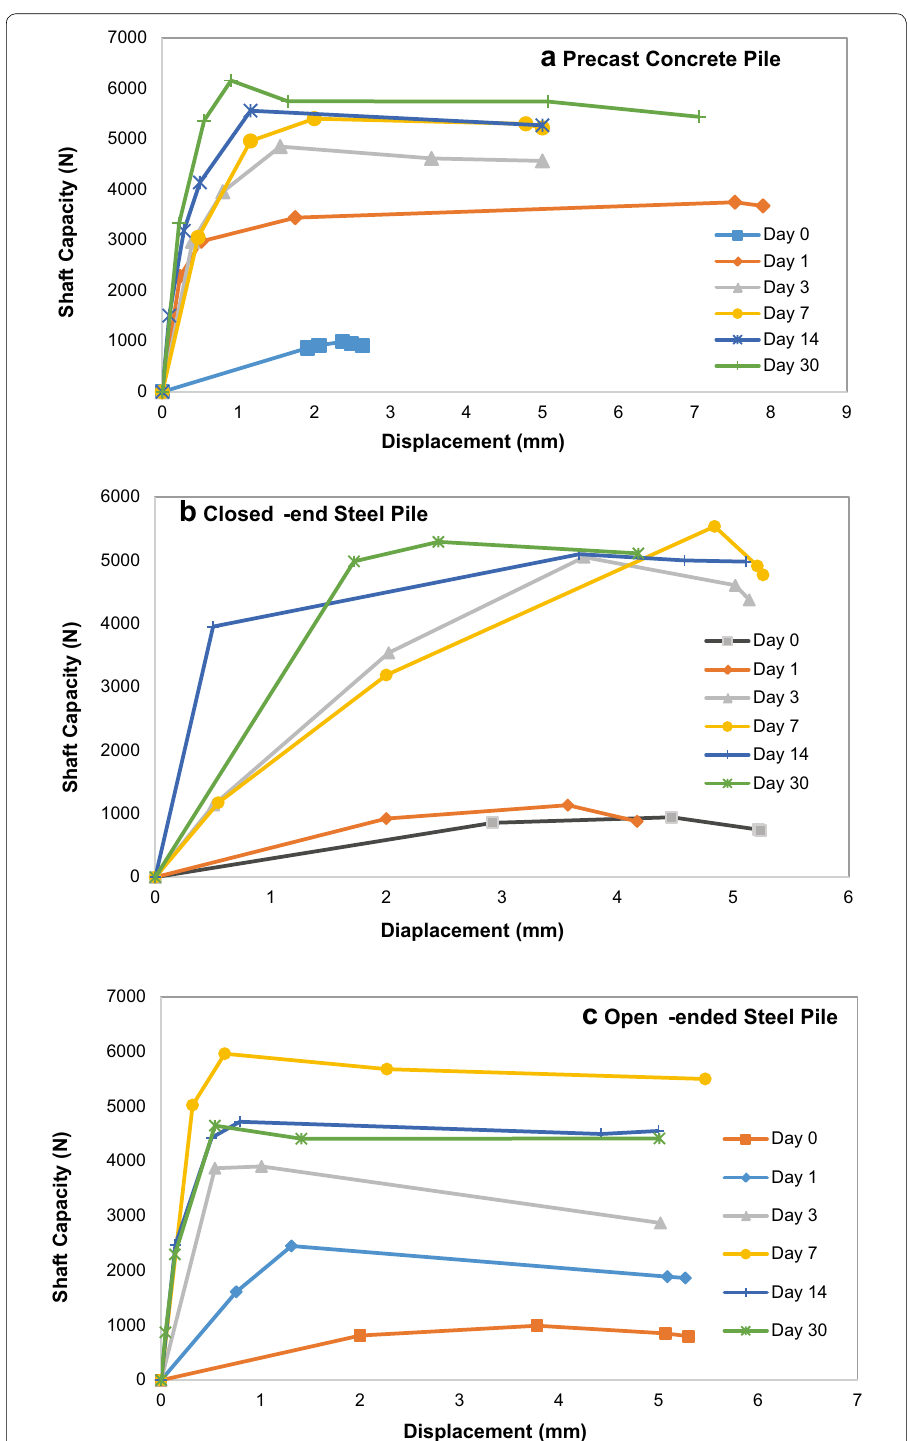
Fig. 5 Transformation in shaft capacity over time, a precast concrete pile; b closed-end steel pile; c open- ended steel